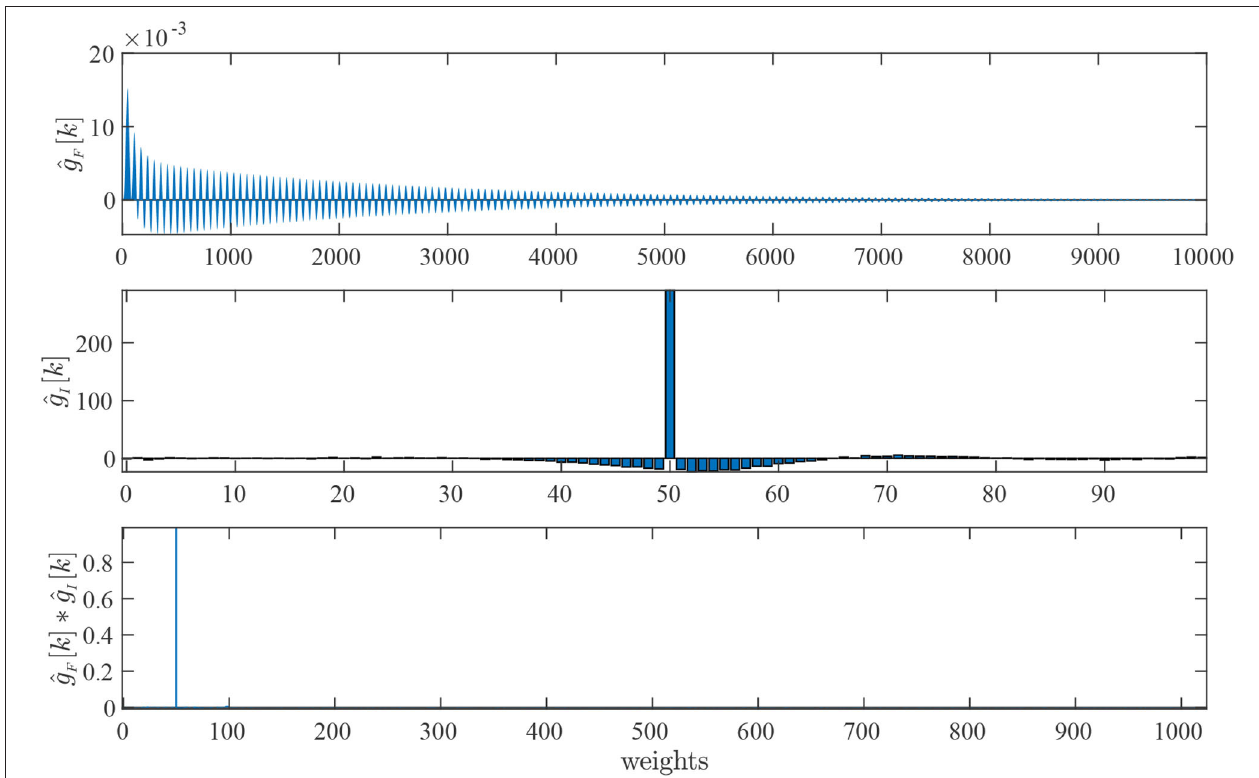
FIGURE 7 | Estimated forward (Top) and inverse (Middle) adaptive filters, and their cascade (Bottom)